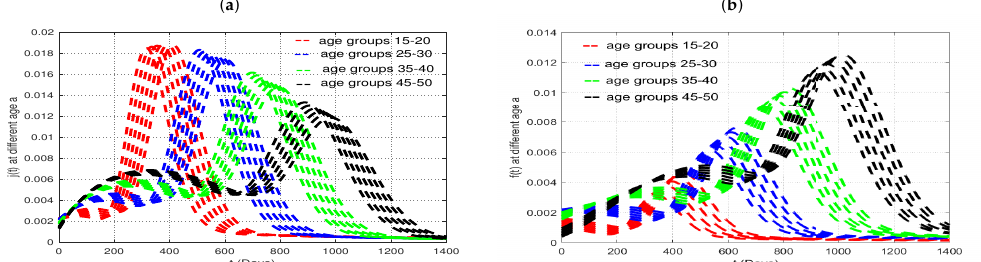
Figure 7. Solution profiles of the densities of unprotected susceptible, protected susceptible, symp- tomatic or confirmed HIV-infectious and AIDS population at age groups (unit is year ) 15 ∼ 20, 25 ∼ 30, 35 ∼ 40, 45 ∼ 50, respectively when R 0 = 2.969 > 1: ( a ) the distributions of j ( t , a ) at different age groups; ( b ) the distributions of f ( t , a ) at different age